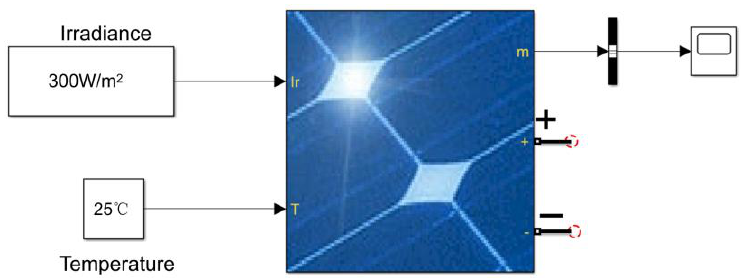
Figure 3. Photovoltaic module.